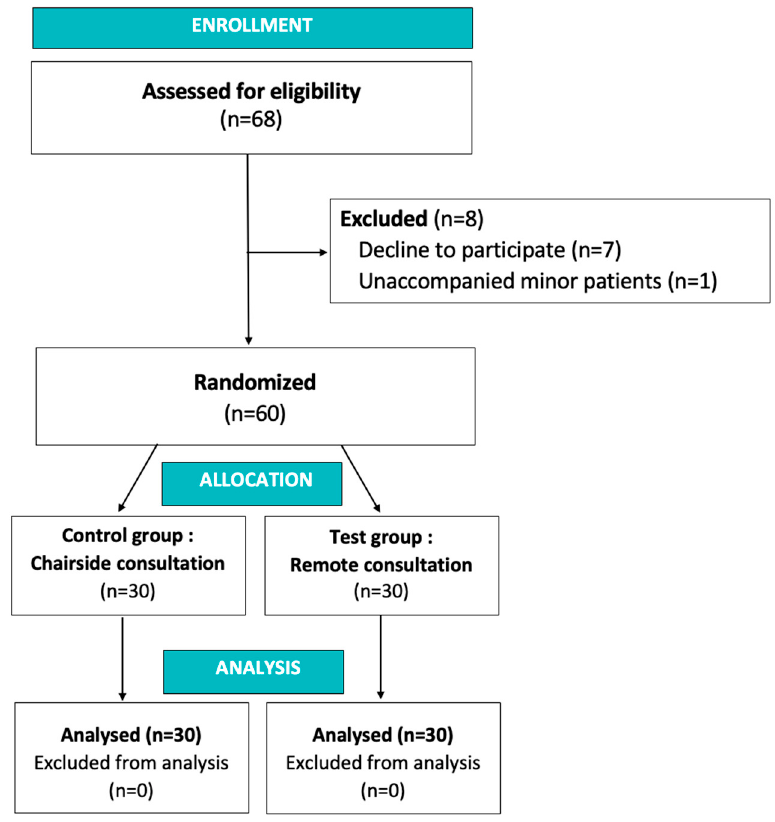
Figure 1. CONSORT Flow diagram.